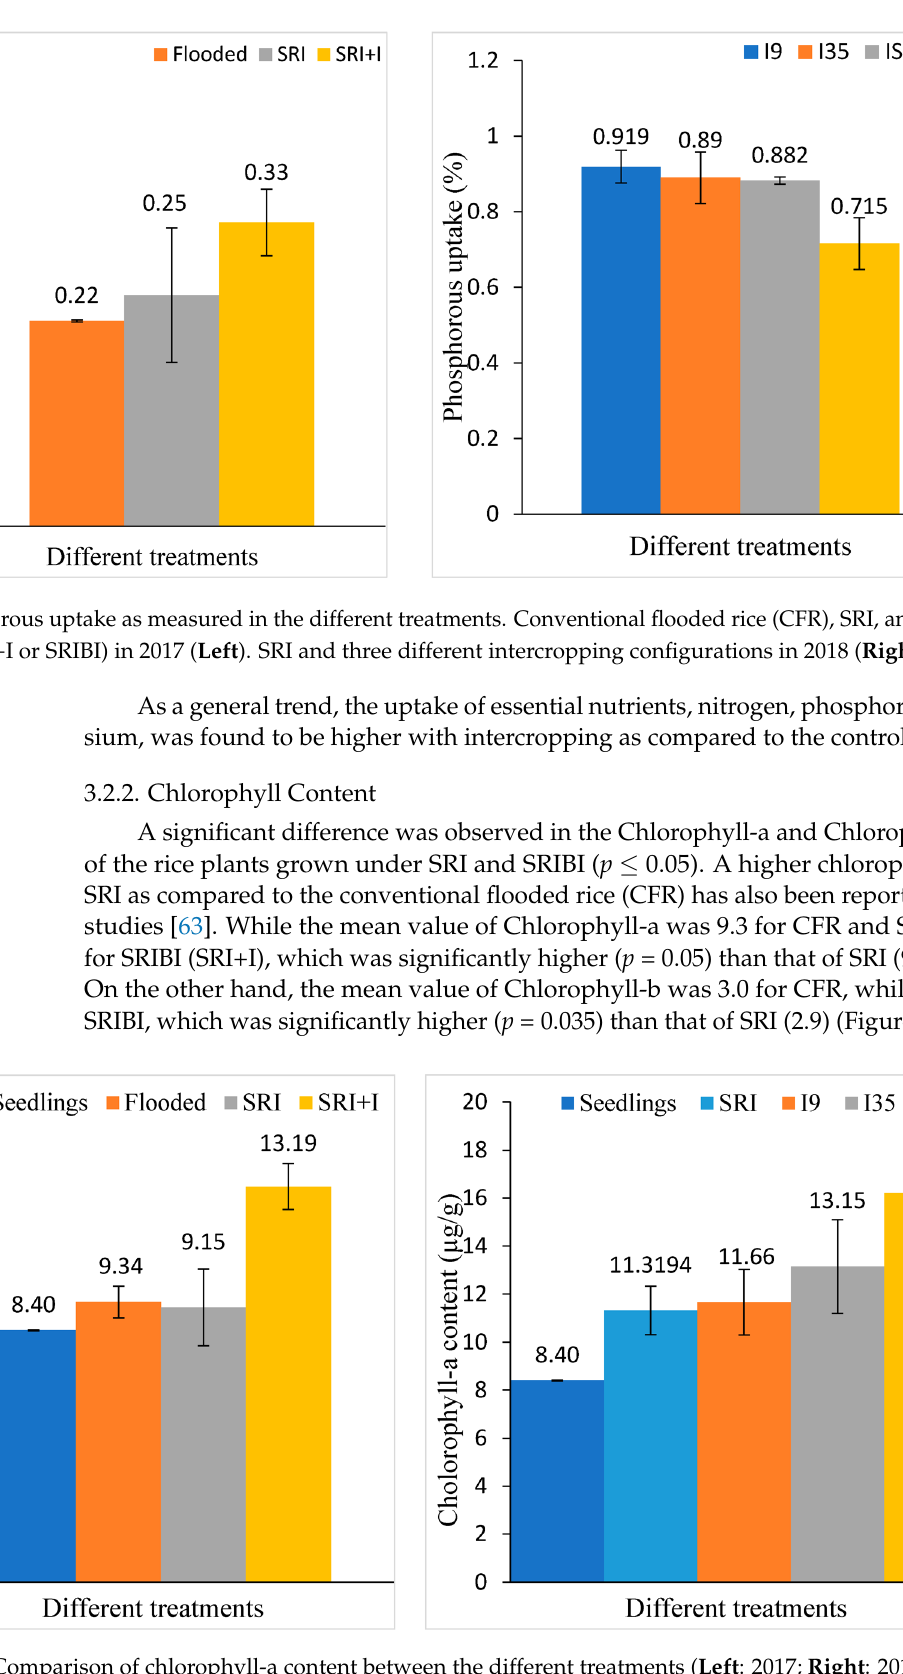
Figure 10. Potassium uptake as measured in the different treatments. Conventional flooded rice (CFR), SRI, and SRI with intercropping (SRI+I or SRIBI) in 2017 ( Left ). SRI and three different intercropping configurations in 2018 ( Right ).